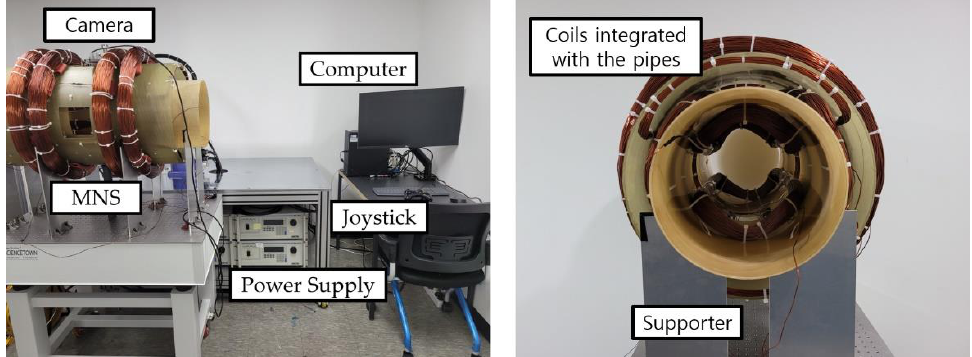
Figure 6. The constructed MNS and experimental setup to actuate a magnetic robot. Table 2. Measured major values of the MNS.